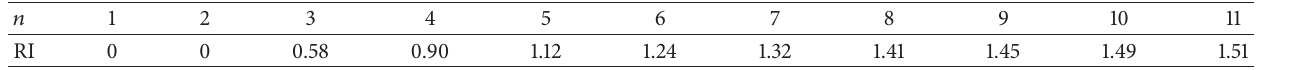
Table 6: Index of RI while “ 𝑛 ” is different.